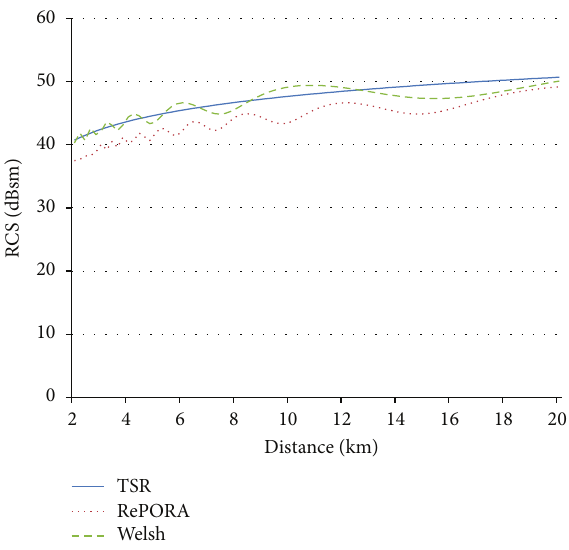
Figure 11: Comparison of the proposed method (in blue), RePORA model (red dotted line), and Welsh’s theoretical expression (green dotted line) in near field for an incidence 𝜃 𝑛 at 3.08 GHz for turbine model 1.